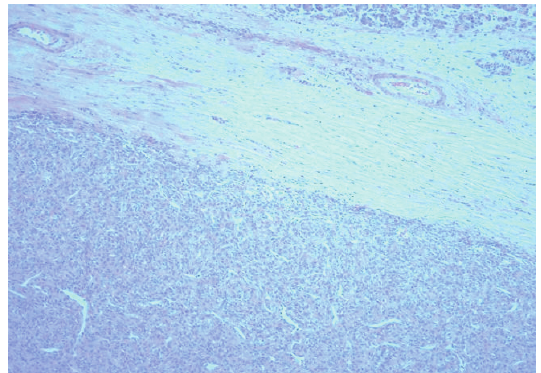
Figure 4 Under microscopy, the neoplasm was composed of diffuse spindle-shaped cells, staghorn vessels, and hyalinized collagen (hematoxylin and eosin staining, ×